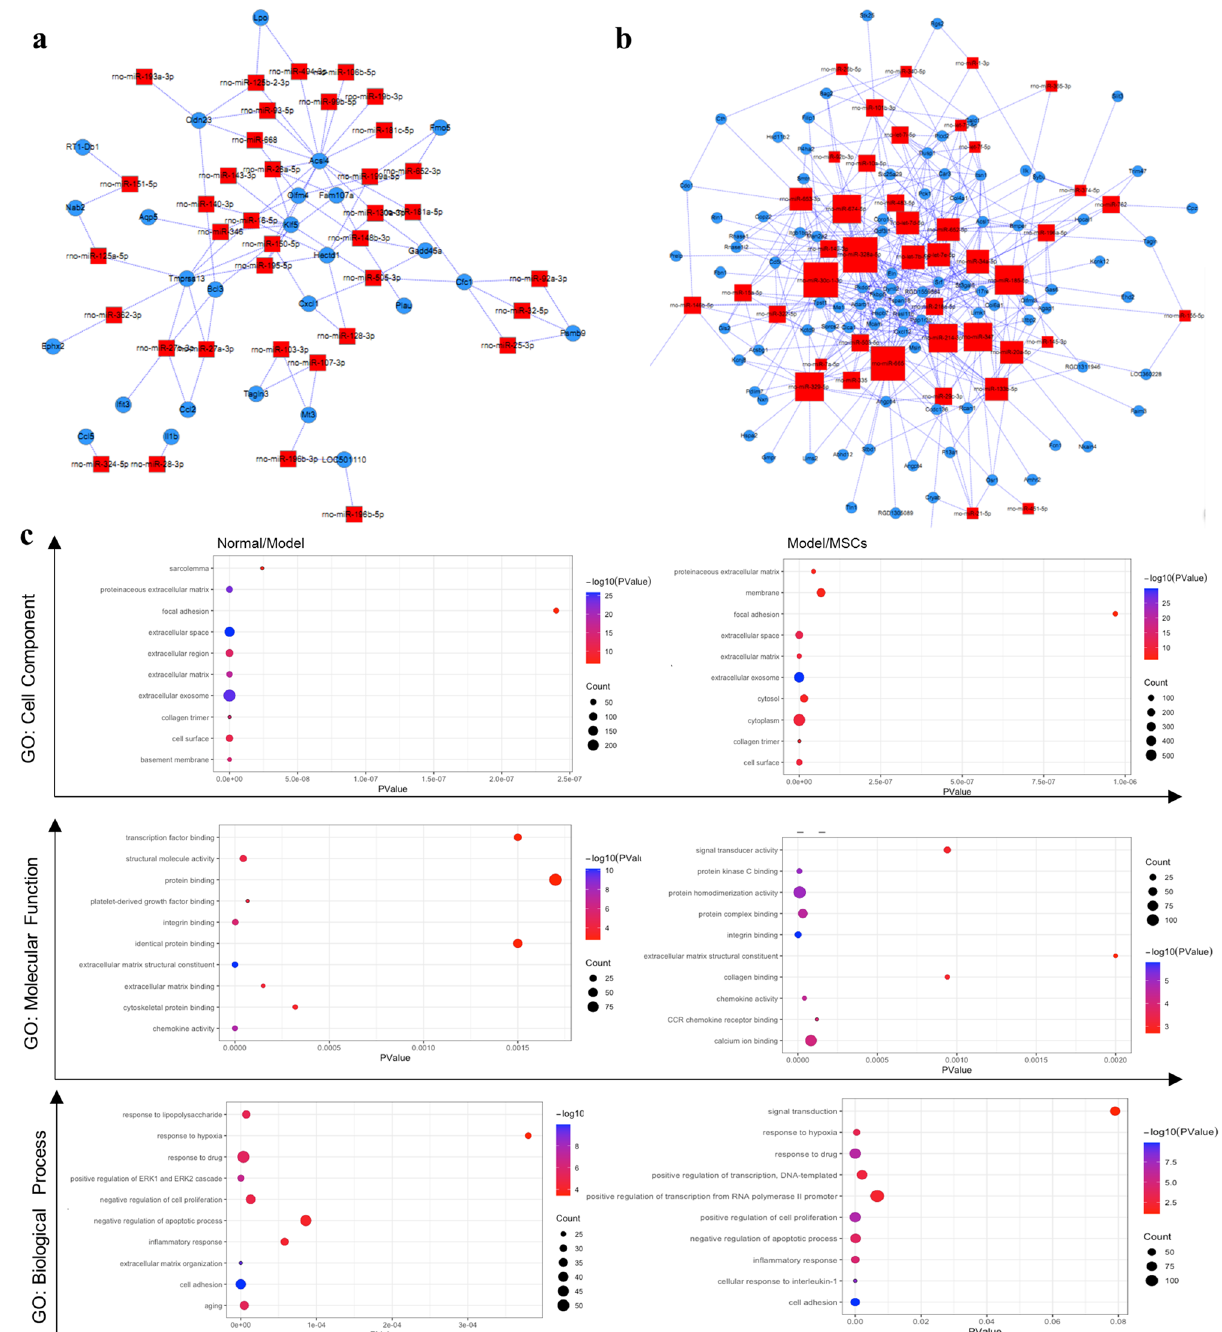
Figure 4. MiRNAs /mRNAs interaction and differently expression gene functional analysis. ( a ) miRNAs up-regulation after injury and down-regulation by UC-MSCs transplantation and their interaction mRNAs. ( b ). miRNAs down-regulation after injury and up-regulation by UC-MSCs transplantation and their interaction mRNAs. ( c ) Representative GO terms (cell component, molecular function and biological process) of the Normal/Model and Model/MSCs enriched